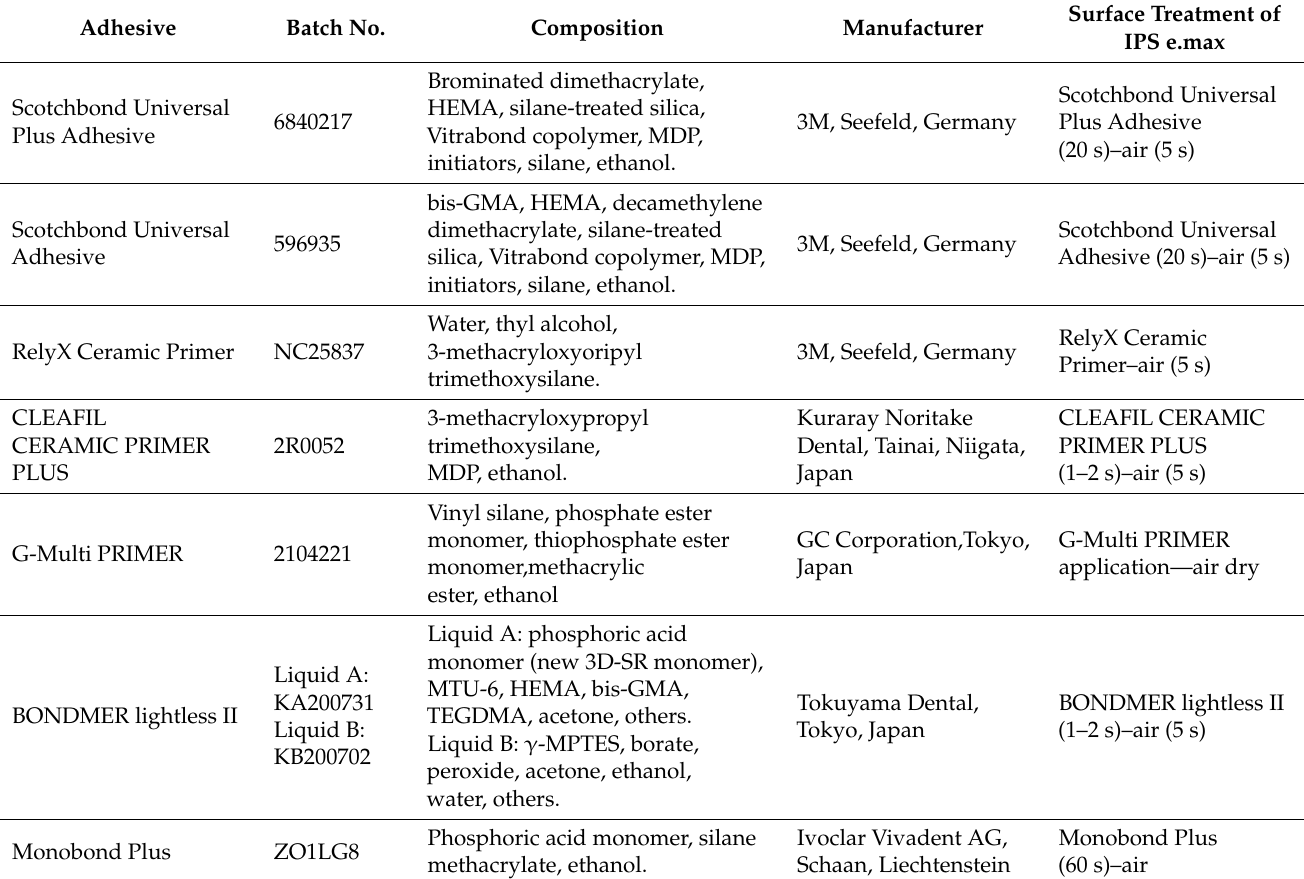
Table 2. Self-etching adhesives and system adhesive